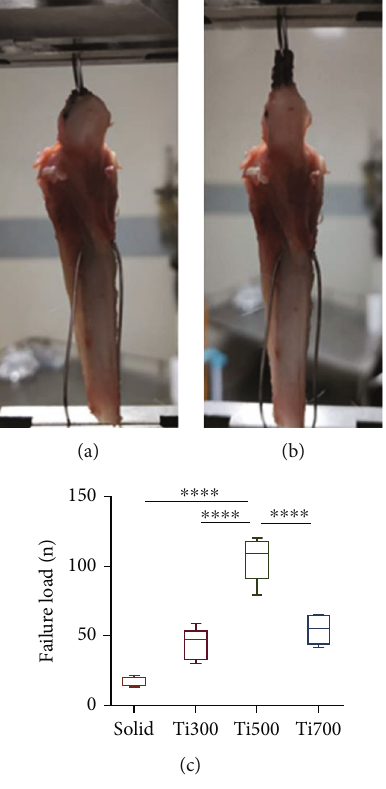
Figure 3: Improvement in biomechanical properties. (a) Fixation of the specimen on a mechanical testing machine. (b) The end point of the test is detachment of the material from the patellar tendon. (c) Statistical analysis of failure loads for each group at week 12 ( n = 8